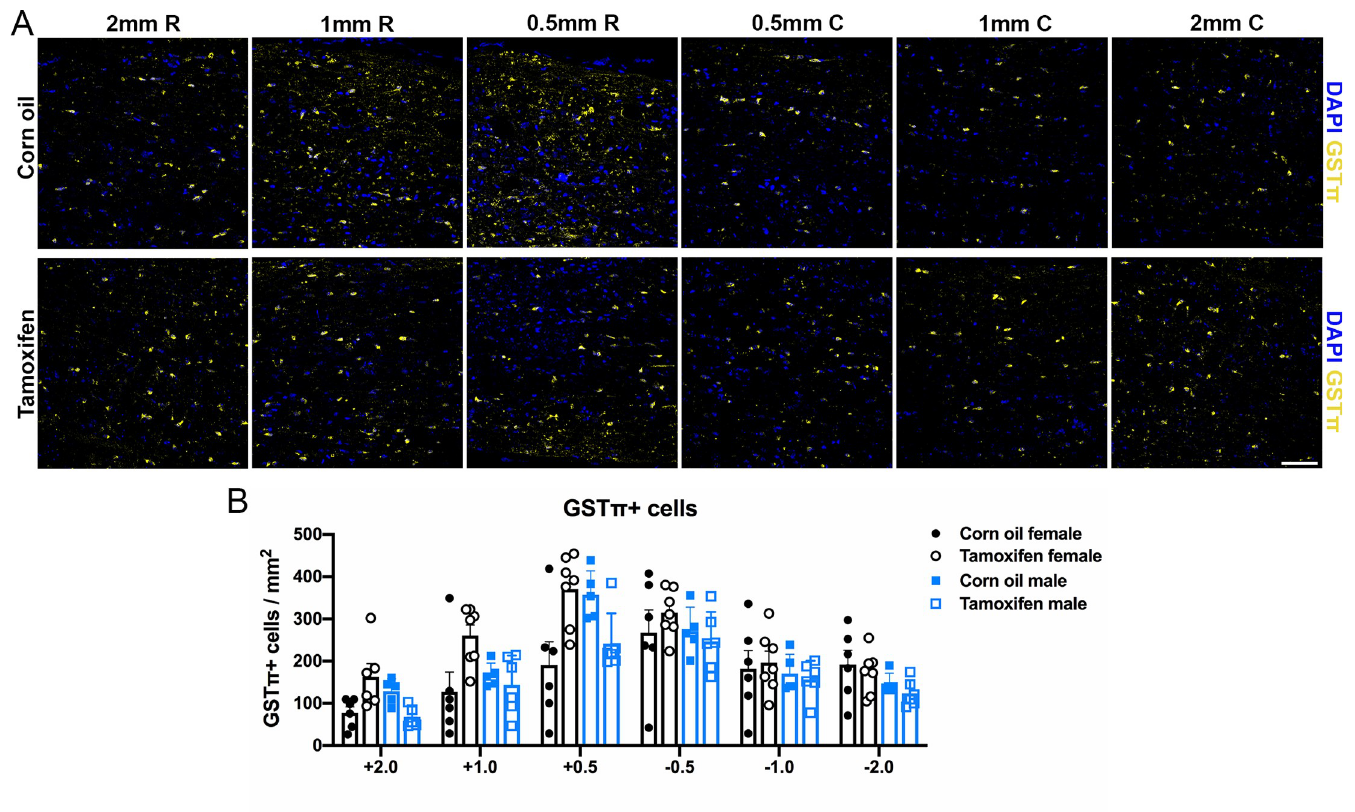
Fig 8. Oligodendrocyte number does not change after delayed short-term tamoxifen gavage. (A) Representative confocal images of OLs (GST π /DAPI+ cells) in the lateral white matter. Scale bar = 75 μ m. (B) Quantification of the total number of OLs 2 mm, 1mm, and 0.5 mm rostral and caudal to the lesion epicenter revealed no significant differences between groups. Data presented as mean + SEM. Two-way repeated measures ANOVA with Sˇı´da´k post hoc test; corn oil female n = 6; tamoxifen female n = 7; corn oil male n = 5; tamoxifen male n = 6.